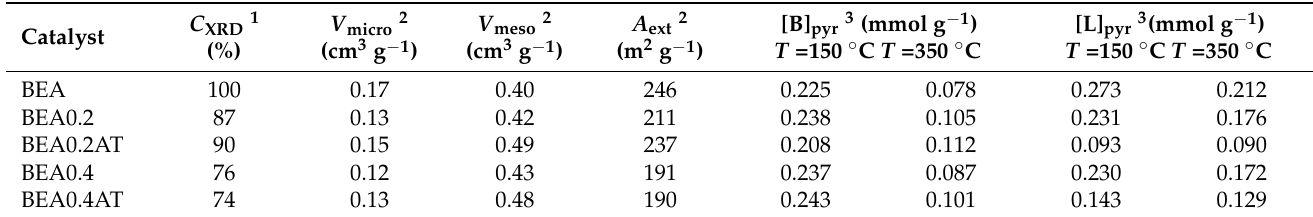
Table 1. Degree of crystallinity, C XRD , textural parameters, and Brönsted [B] pyr and Lewis [L] pyr acid sites